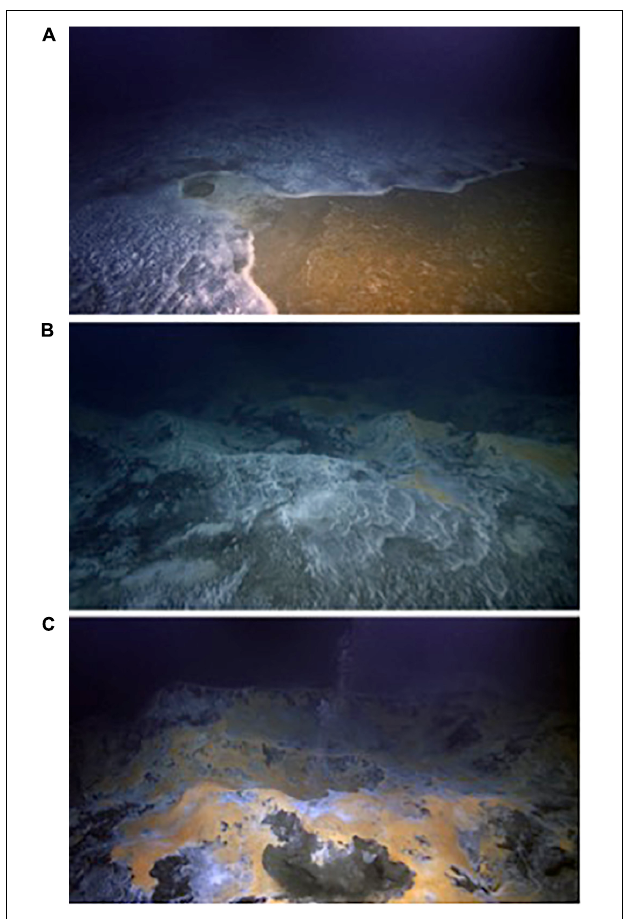
FIGURE 3 | Triton seep overview. Still images captured from the forward looking HD Video Camera mounted on ROV Hercules during a preliminary ∼ E-W reconnaissance transect across the Triton mud volcano seep site at the base of Redondo Knoll . (A) At the periphery of the site, monotonous brown sediment transitions into rising terrain covered in extensive white microbial mats; (B) closer to the center of the site, there is a sharp transition across the rim of a pronounced depression ( ∼ 10 m in diameter, 0.5 m deep) from white to brightly colored yellow–orange microbial mat covering the inner walls and floor of the mud volcano; and (C) at the center of the site, a vigorous bubble plume was observed rising from a pit of dark gray sediment that was devoid of any visible microbial life. Copyright Ocean Exploration Trust,